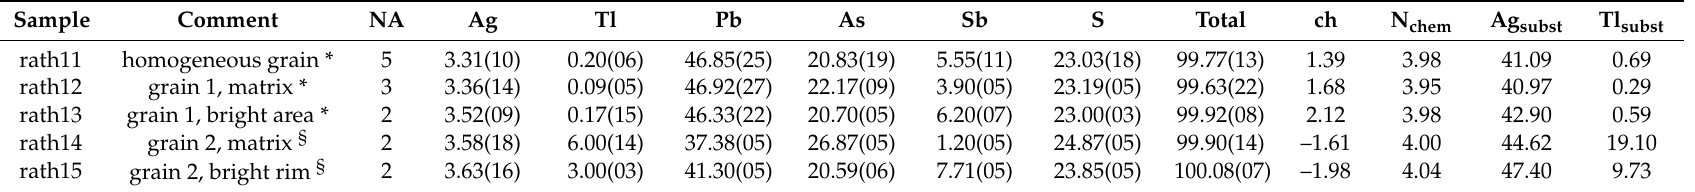
Table 3. Selected chemical-analytical data for Sb-enriched areas of some of the studied rathite samples, and derived chemical and structural parameters.